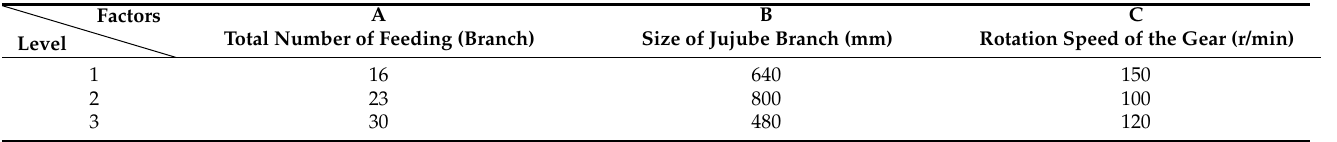
Table 3. Influence factors and levels of